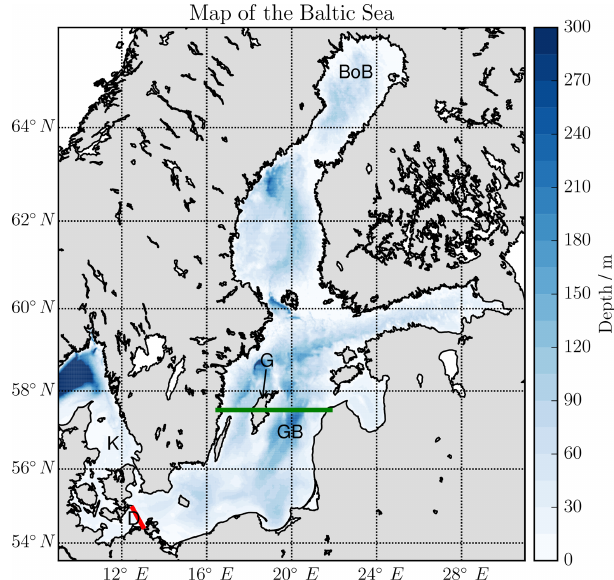
Figure 6. Map and bathymetry of the Baltic Sea. K: Kattegat, D: Darss Sill and the Darss Sill transect (red), G: the Gotland island, GB: Gotland Basin and the Gotland transect (green), BoB: Bothnian